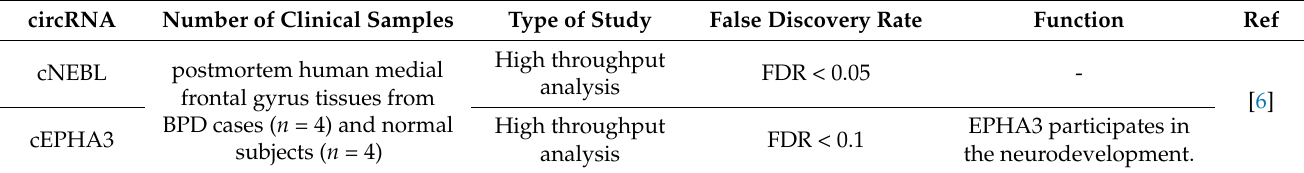
Table 1. Summary of function of up-regulated circRNAs in